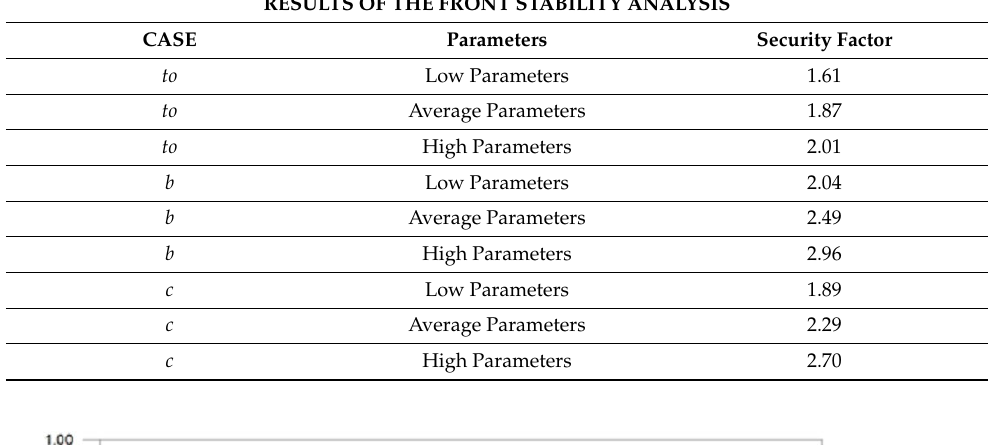
Table 5. Results of the front stability analysis.